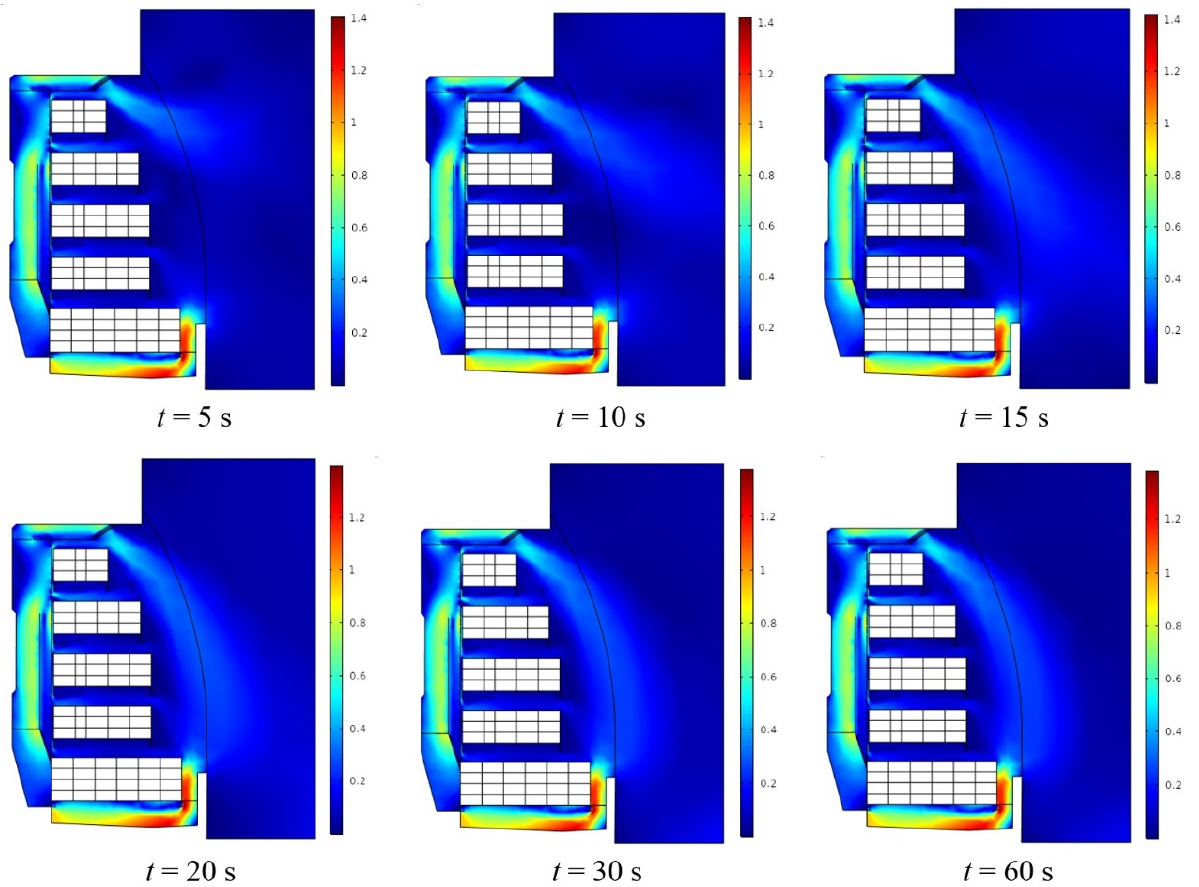
Figure 7. Air velocity (m/s) distribution in the middle plane of the modified cabinet.